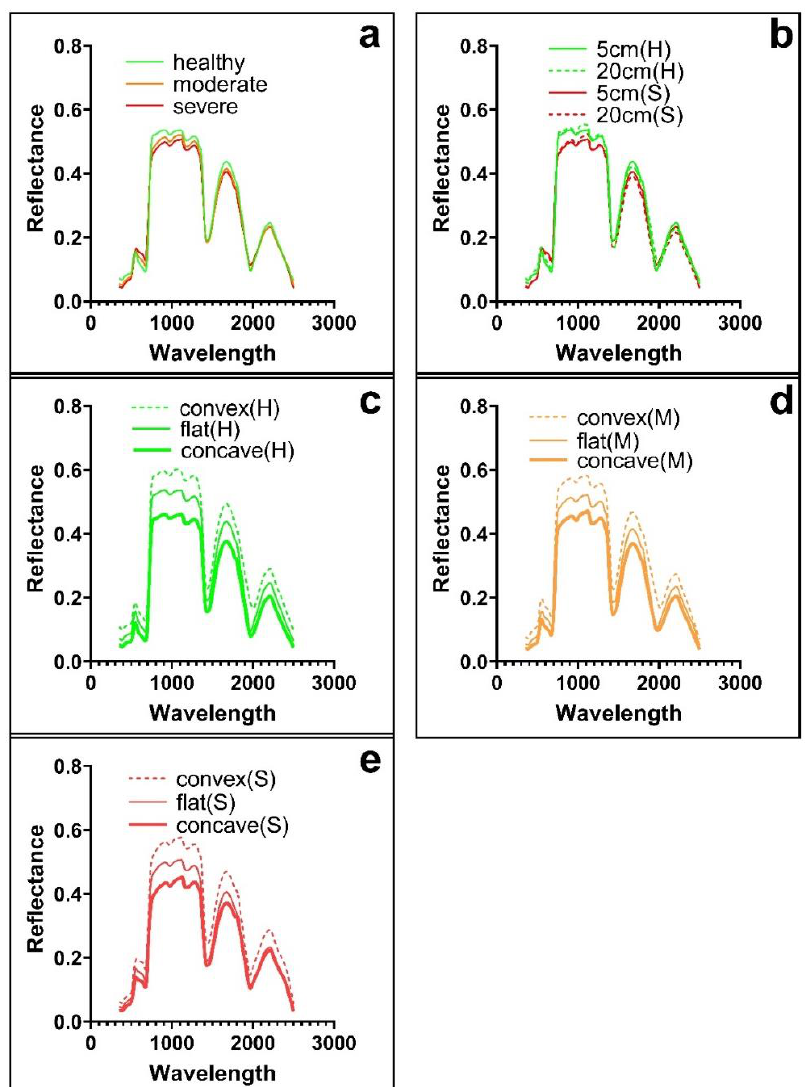
Figure 6. Comparison of reflectances of corn leaves with different severities ( a ), different measuring heights ( b ) and different leaf curvatures ( c – e ). H, M and S in the legend denote healthy, moderate and severe, respectively.